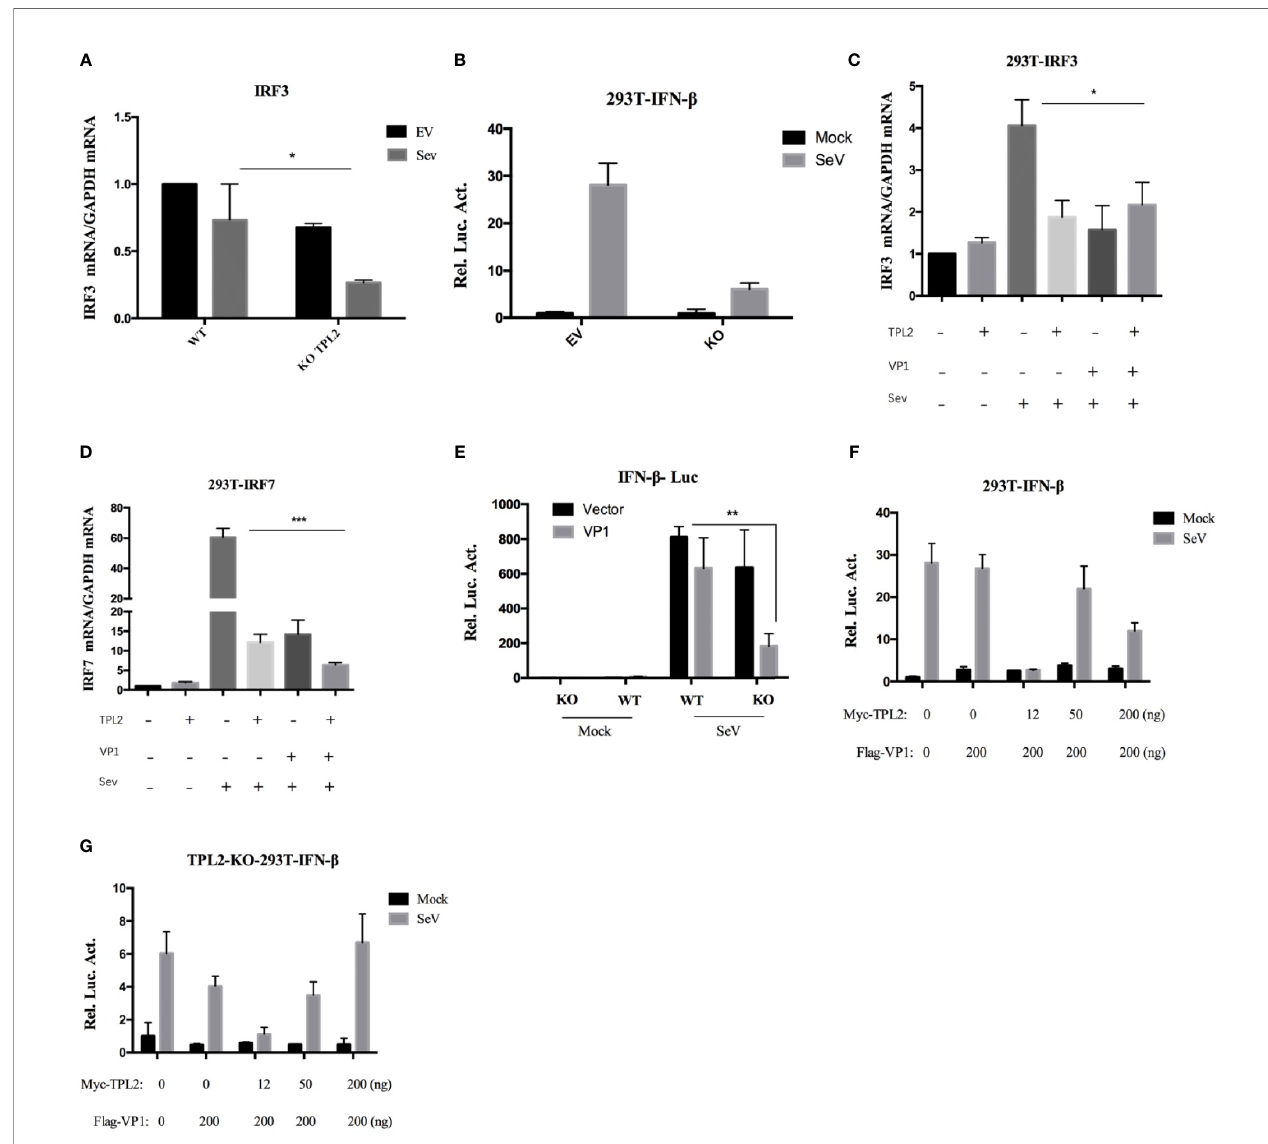
FIGURE 8 | overexpression of TPL2 restored VP1-induced inhibition of IFN- b signaling. Detection of IRF3 and IFN- b transcription in HEK293T-WT and HEK293T- TPL2 -/- cells both with or without SeV infection using RT-PCR (A) and luciferase assays (B) . (C, D) HEK293T cells were transfected with Flag-VP1 or TPL2. At 24 hpt, the cells were mock-infected or infected with SeV for an additional 12h; qRT-PCR was used to detect IRF3 and IRF7. (E) HEK293T-WT and HEK293T- TPL2 -/- cells were transfected with Flag-VP1, empty vector PCAGG, and Flag-VP1 or TPL2 expression plasmids (F, G) . At 24 hpt, the cells were mock-infected or infected with SeV for an additional 12h after which luciferase assays were